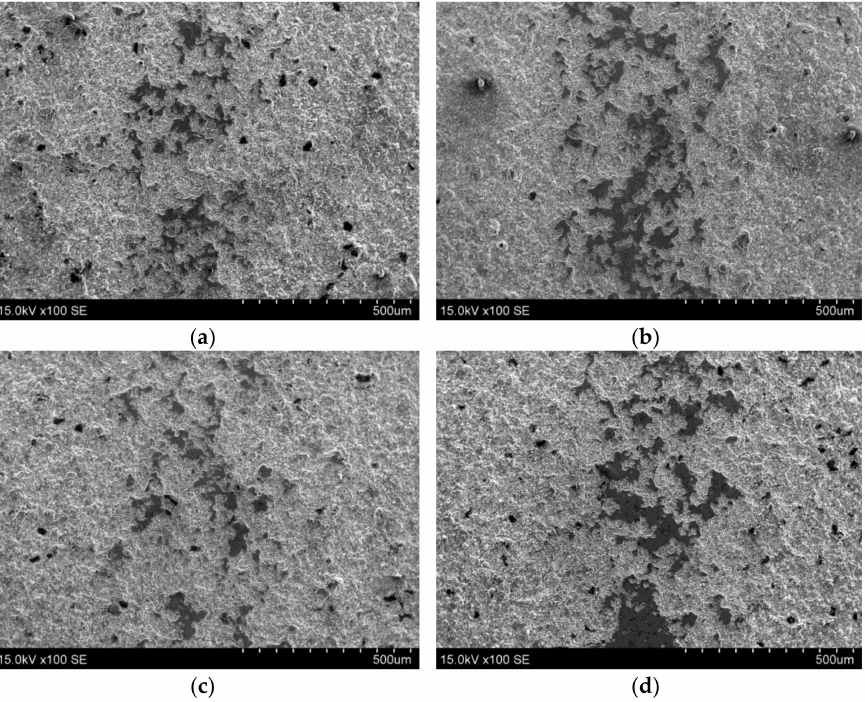
Figure 5. Wear scars images of ( a , b ) Cr 2 O 3 and ( c , d ) Cr 2 O 3 -SiO 2 -TiO 2 coatings after tribological test with ( a , c ) 1 N and ( b , d ) 3 N